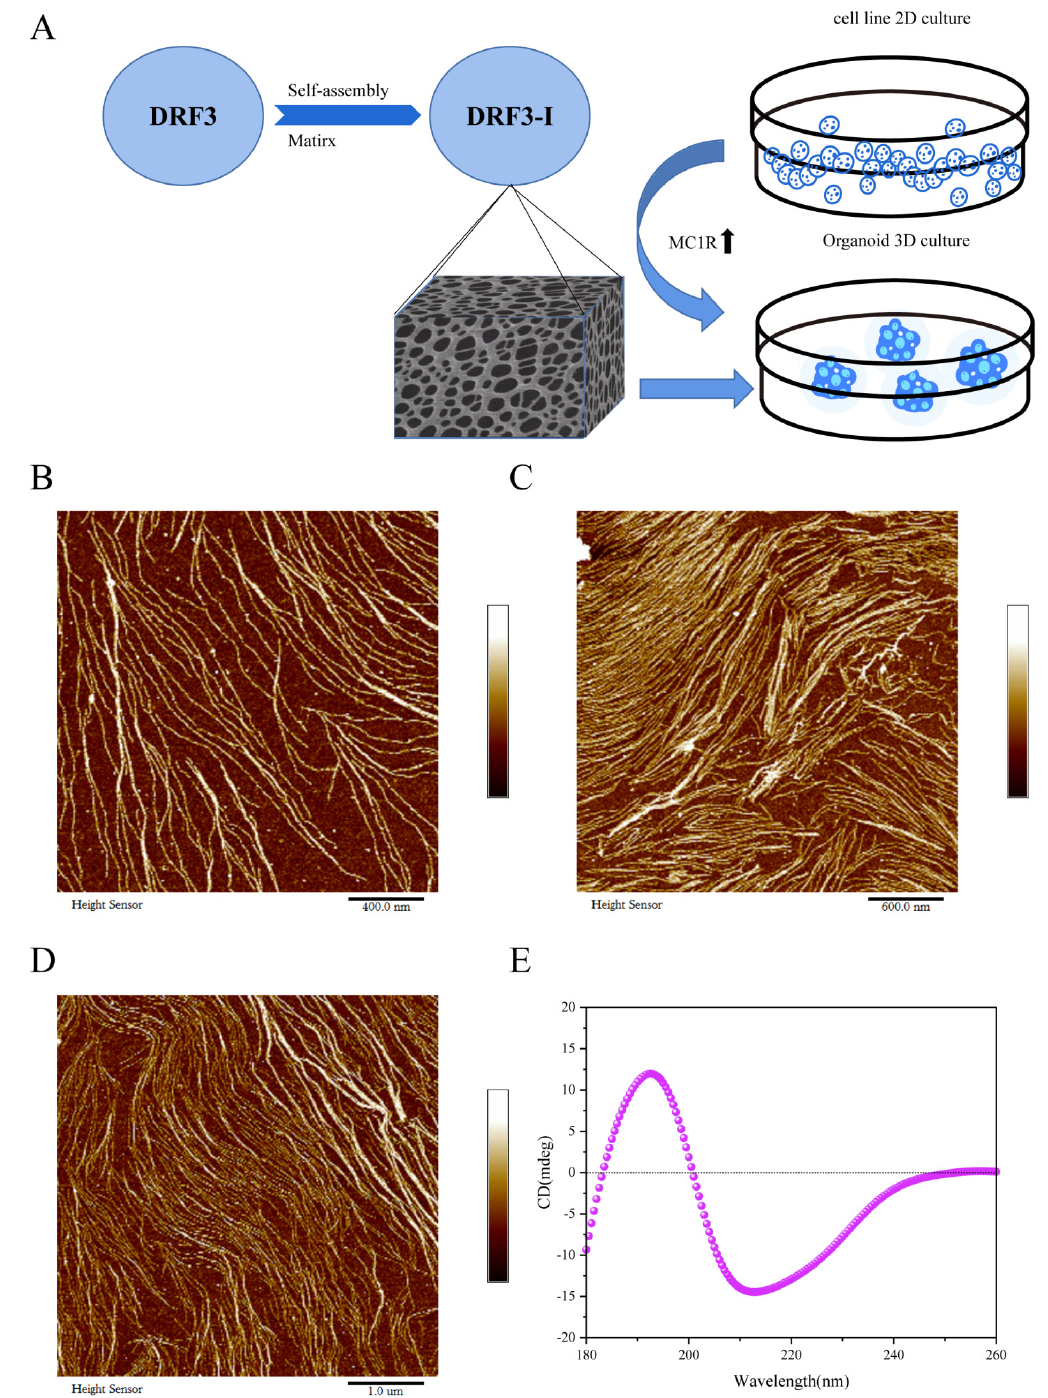
Figure 2. Microscopic morphology and secondary structure analysis of DRF3. ( A ) Schematic illus- tration of detection in the 3D culture with SAP-Matrix compared to the 2D cell line. ( B – D ) AFM morphology of DRF3 at 400 µ m, 600 µ m and 1 µ m. The fiber width of DRF3 ranges from 7 to 24 nm, with an average width of 11.67 nm. ( E ) Secondary structure of DRF3. DRF3 has a positive peak around 195 and a negative peak around 216.